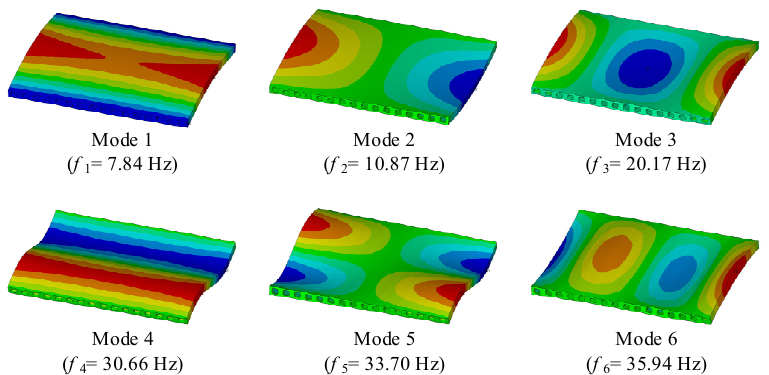
Figure 3. First six modes of the entity model.